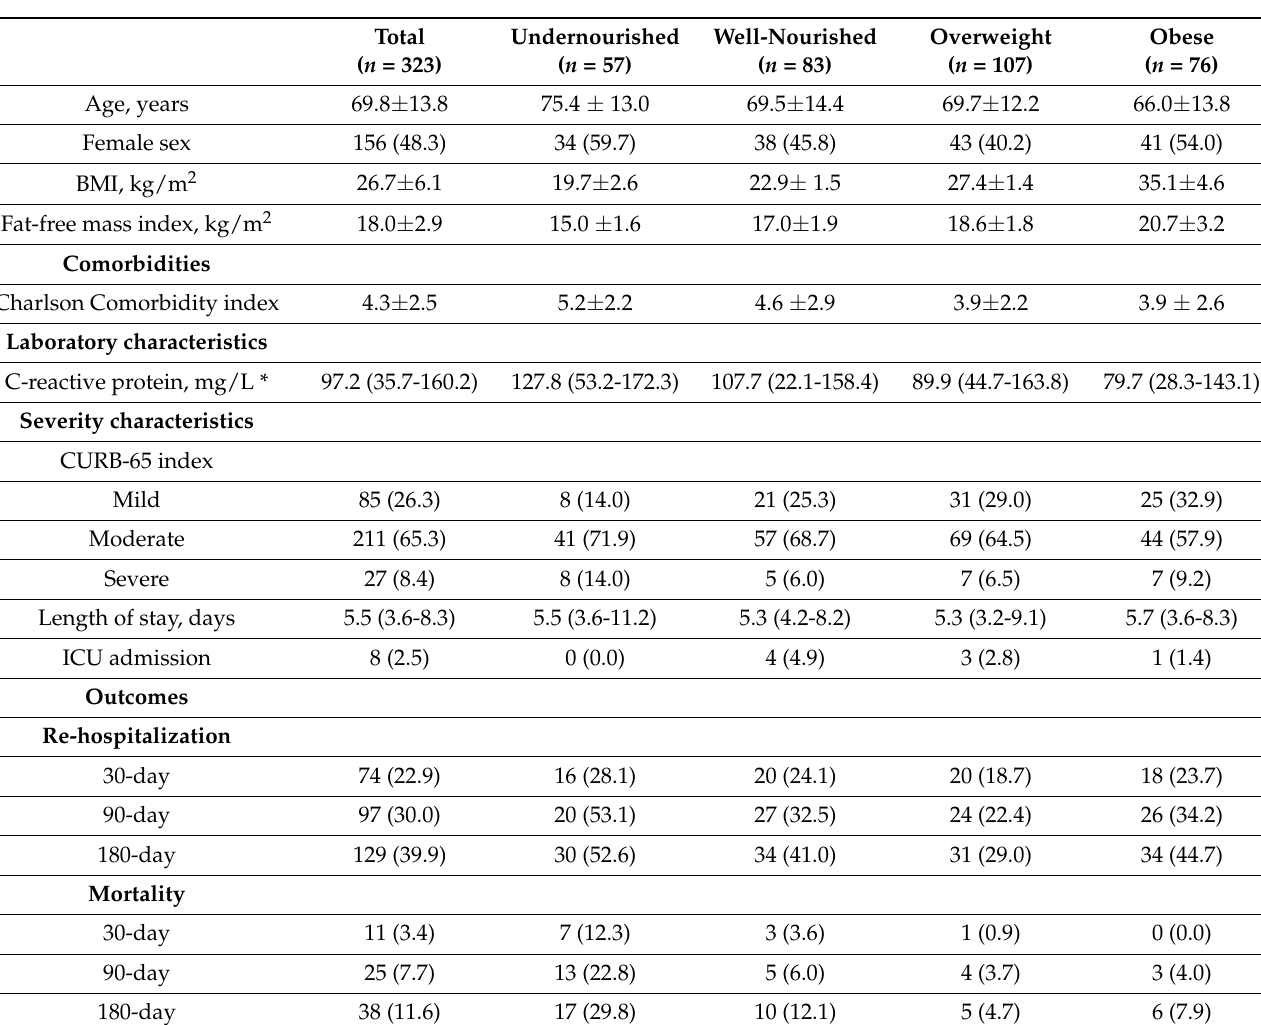
Table 2. Characteristics during hospital admission and outcome measures among undernourished, well-nourished, overweight, and obese patients hospitalized with community-acquired